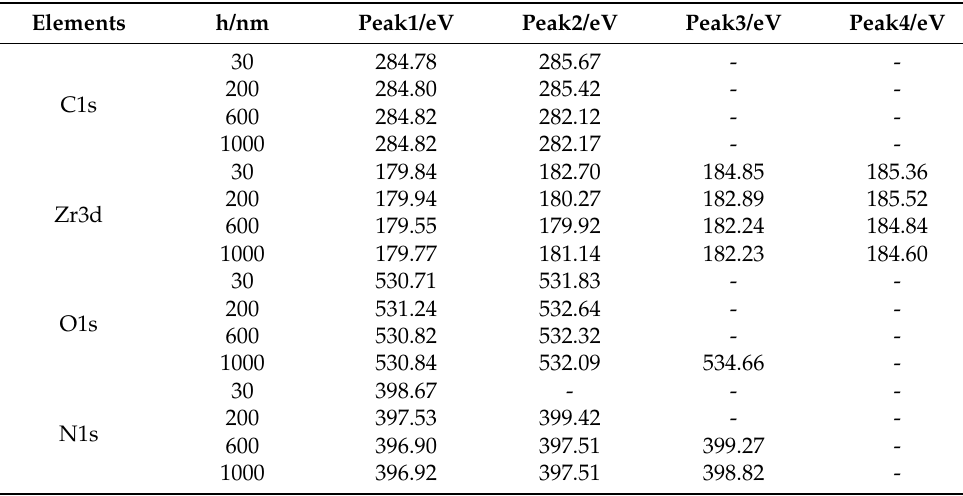
Table 4. Binding energy values of XPS narrow spectrum of the nitride